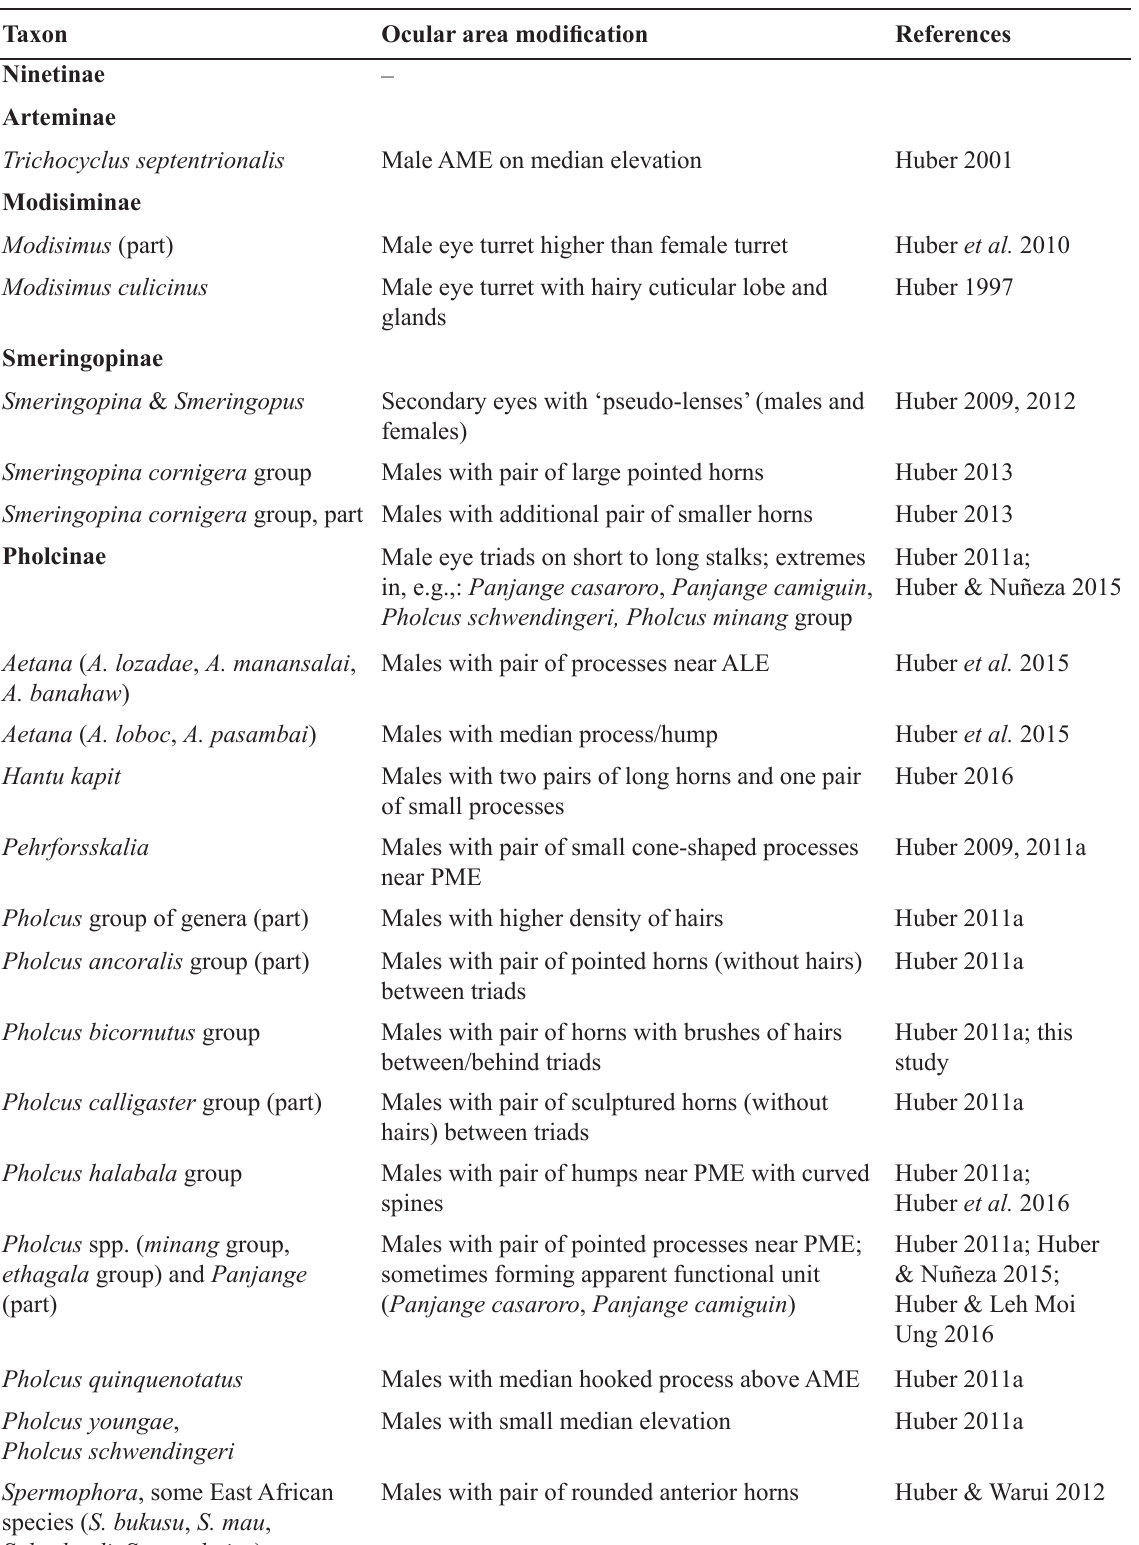
Table 1. Ocular area modifications in